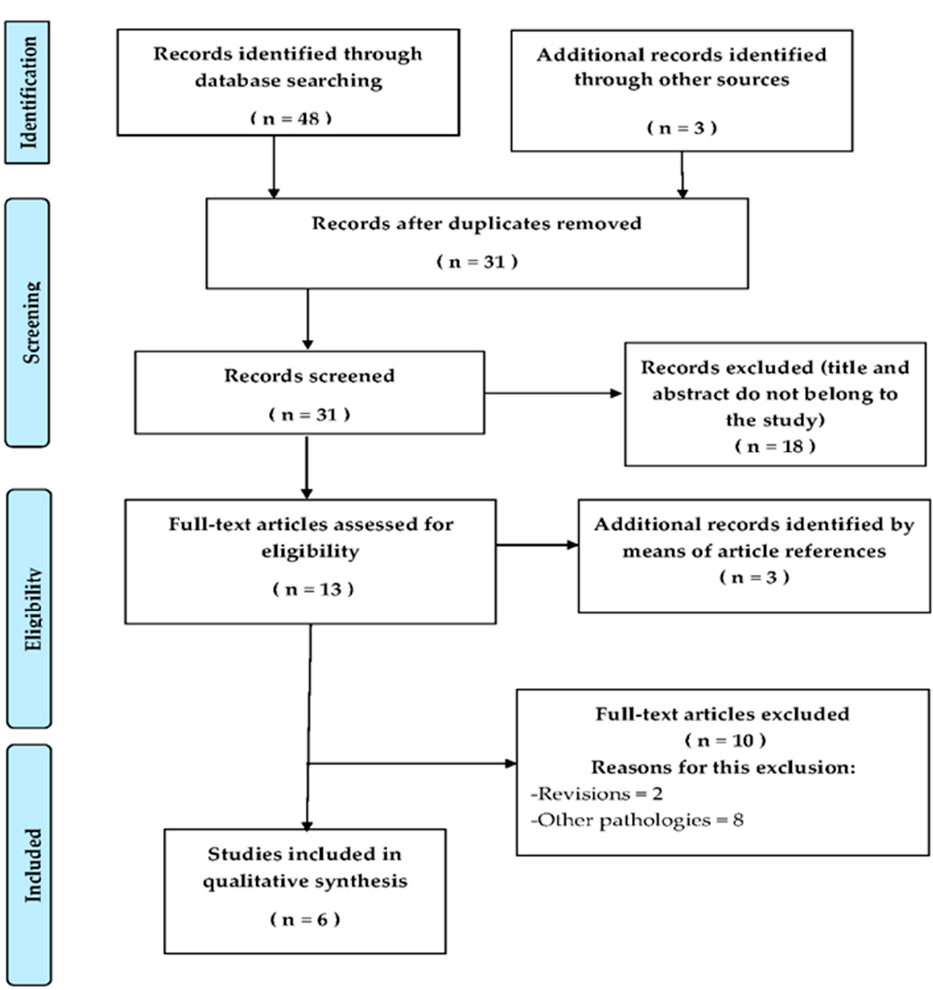
Figure 1. Flow diagram of the selection process of the systematic review following the PRISMA recommendations.